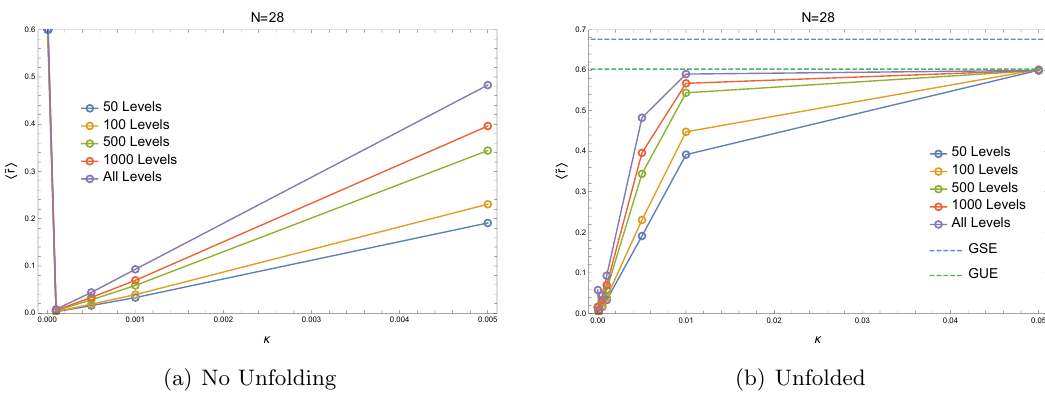
Figure 20 . The mean value of the ~ r -parameter for N = 28 (a) with unfolding and (b) without unfolding. The average is performed over M = 100 ensembles, respectively. The ~ r -parameter are computed subsectors of the spectra including M levels starting from the ground state ( M = 50 ; 100 ; 500 ; 1000 ; All).